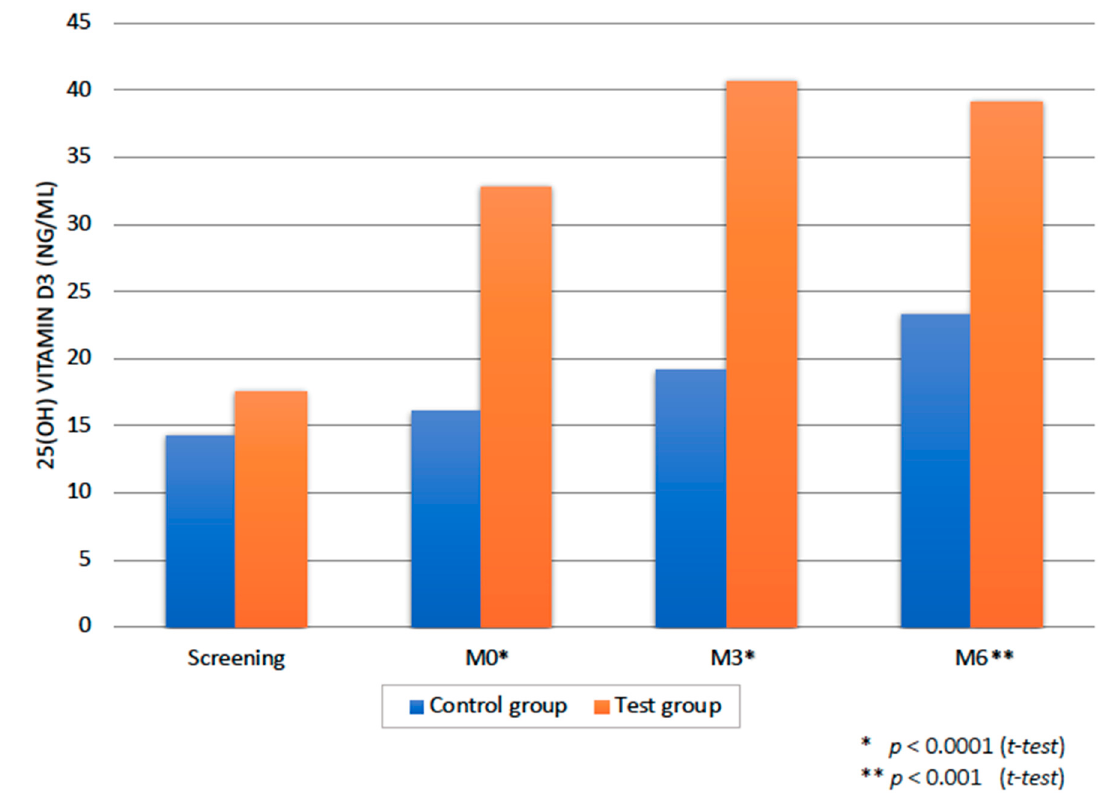
Figure 1. 25(OH) vitamin D3 status over study timepoints. The p- values show inter-group difference at M0, M3 and M6 timepoints. * Significant effect of intensity.